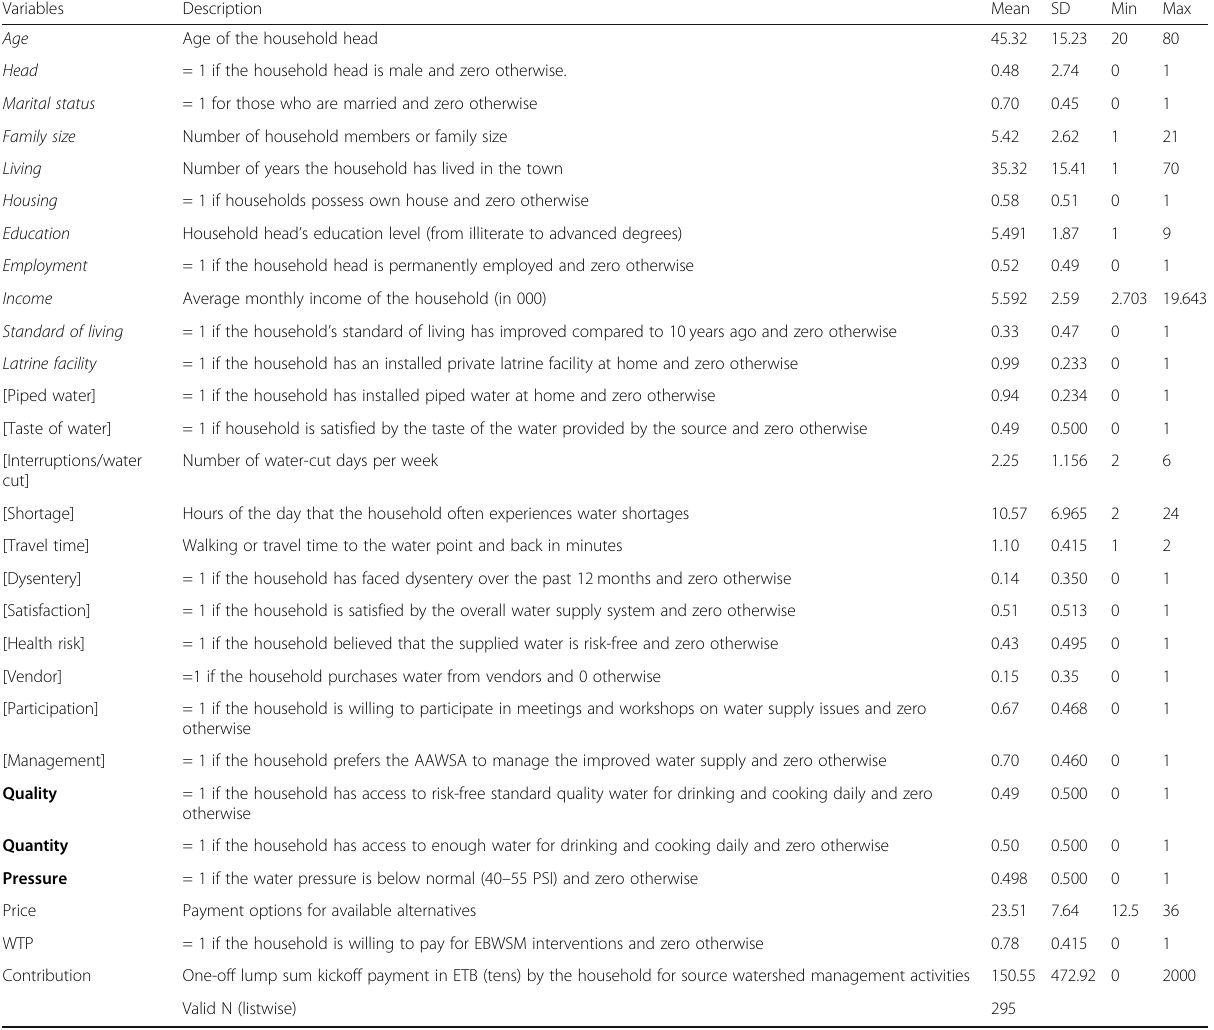
Table 4 Descriptive statistics for the variables used in this study: mean and standard deviation (SD)